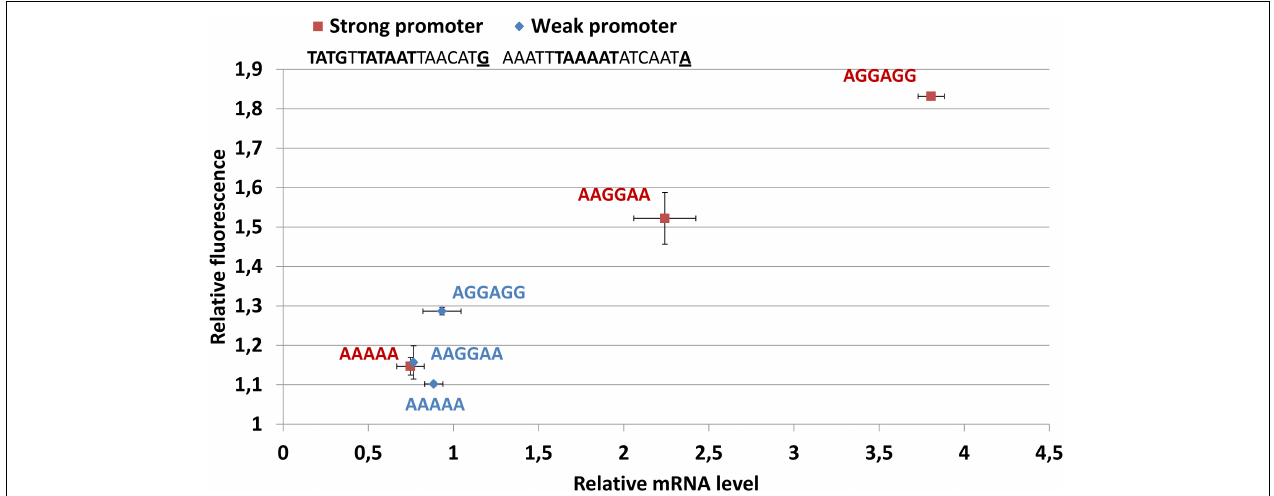
FIGURE 3 | The abundance of mMaple2 mRNA and protein produced in genetic constructs with different strengths of promoter and ribosome-binding site. The key promoter determinants (EXT-element, -10-box, and initiator nucleotide) are underlined and highlighted in bold. The ribosome binding sites are shown on the chart in red for strong promoter constructs and in blue for weak promoter